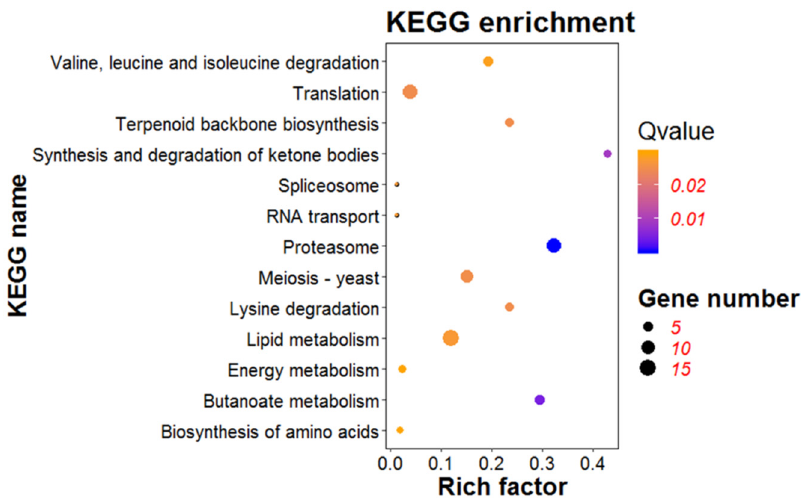
Figure 7. Kyoto encyclopedia of genes and genomes (KEGG) enrichment analysis of differentially expressed genes (DEGs). The bubble graph displays KEGG items on the Y-axis and rich factor on the X-axis. The size of bubbles represents the number of genes. The color of bubbles represents Qvalue.